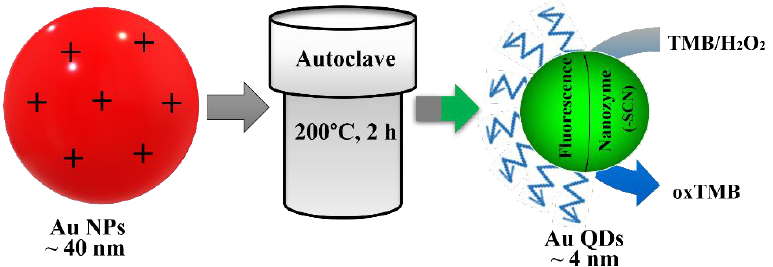
Figure 1. Schematic illustration of the present SCN − detection.